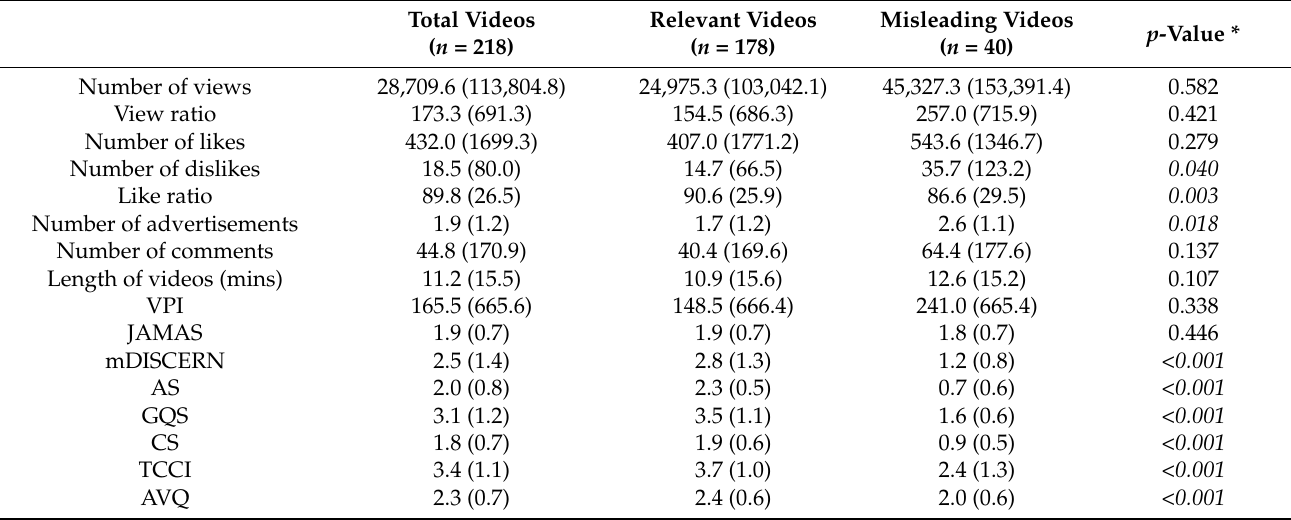
Table 1. Characteristics of videos included for